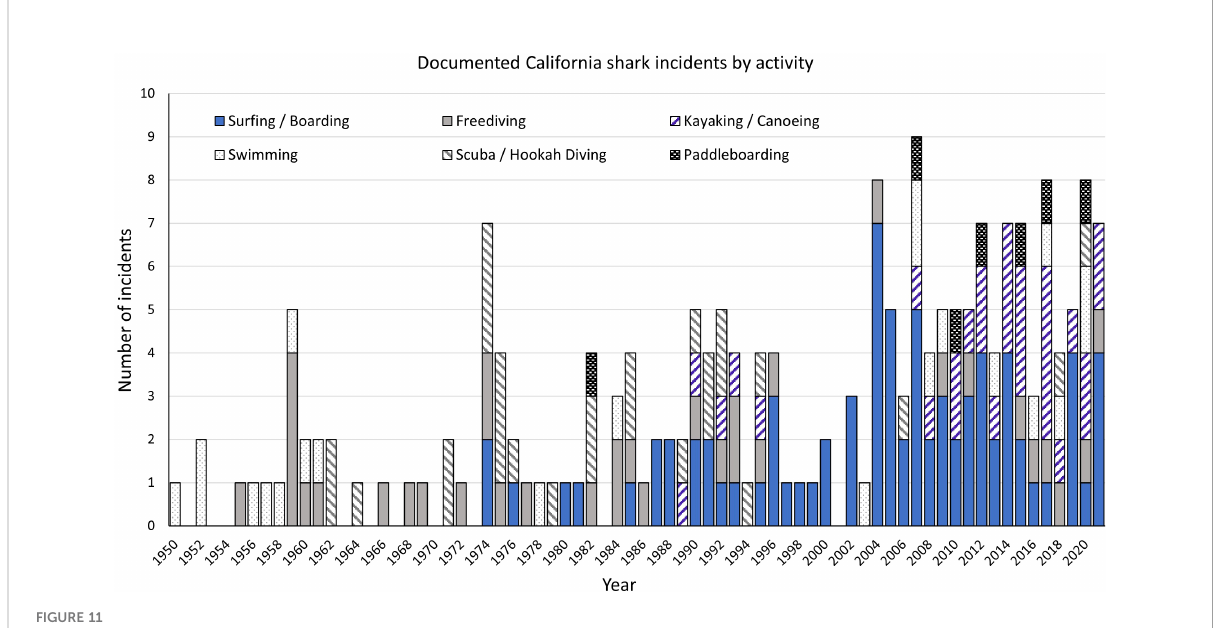
FIGURE 11 Documented California shark incidents by activity and year between 1950 and